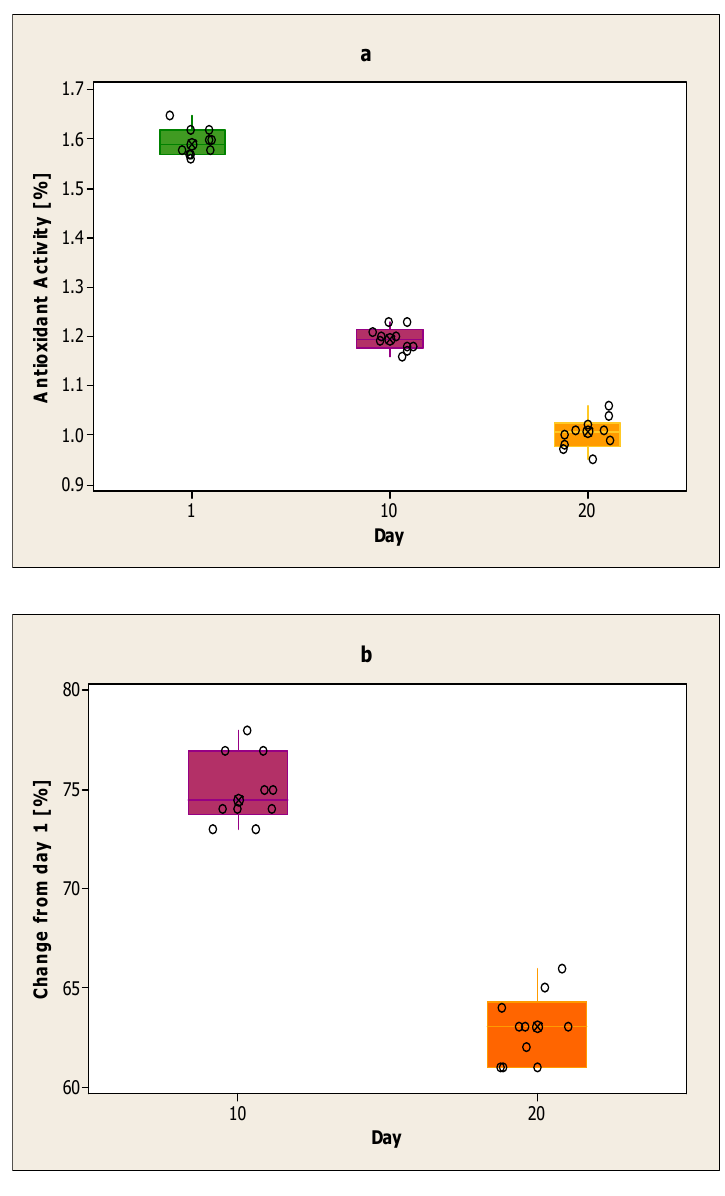
Figure 2. ( a ) Antioxidant activity of the yoghurt sample from cow milk with the addition of volatile mint oil encapsulated in sodium alginates on the first day, the 10th day and the 20th day; ( b ) Decline on day 10 and day 20 for the yoghurt sample from cow’s milk with the addition of volatile mint oil encapsulated in sodium alginates compared to day one.